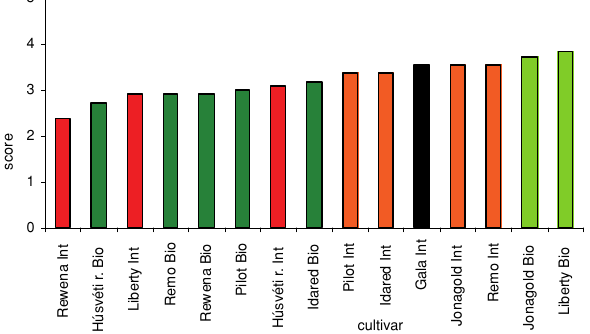
Figure 3. The range of samples rated according to flesh consistency (Debrecen,